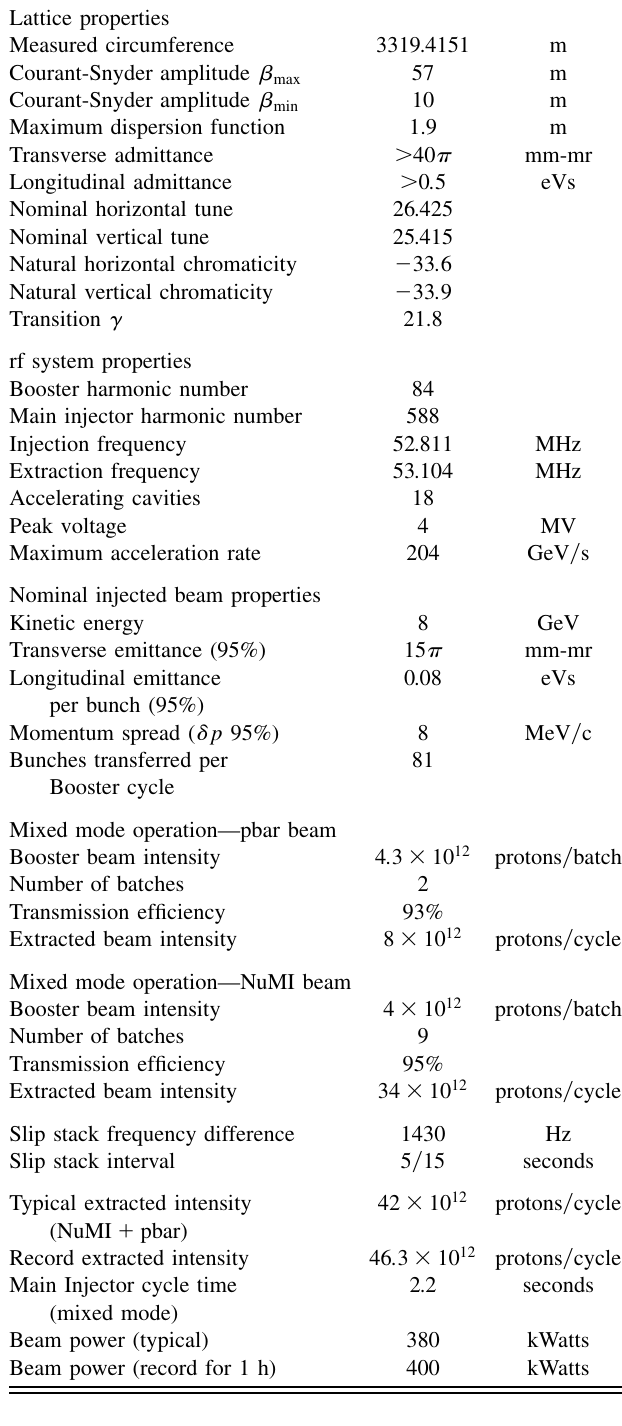
TABLE I. Main Injector properties including typical beam properties for high intensity 120 GeV operation.